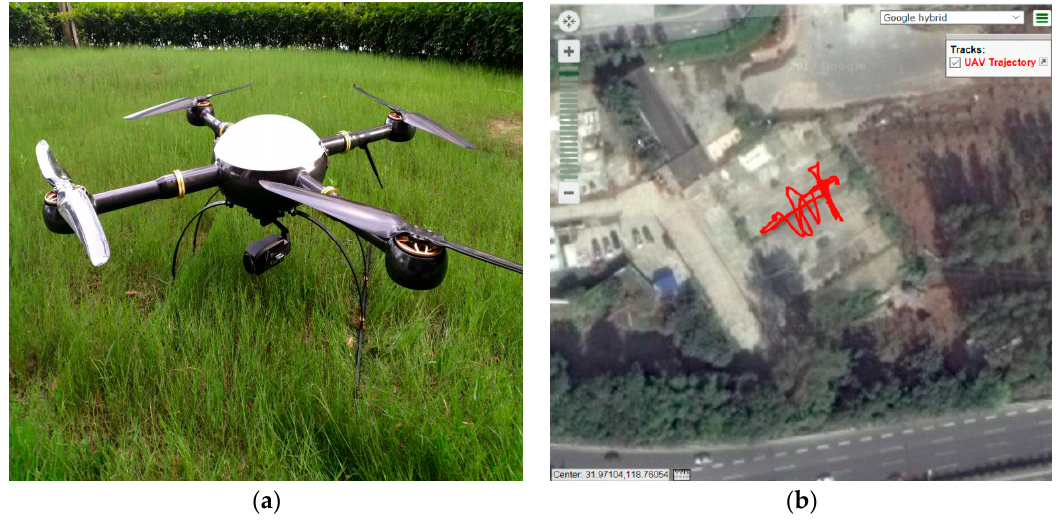
Figure 5. ( a ) The Unmanned Aerial Vehicle (UAV) used in the field test and ( b ) its test trajectory. Table 2. Defined fault sessions and the time duration of the